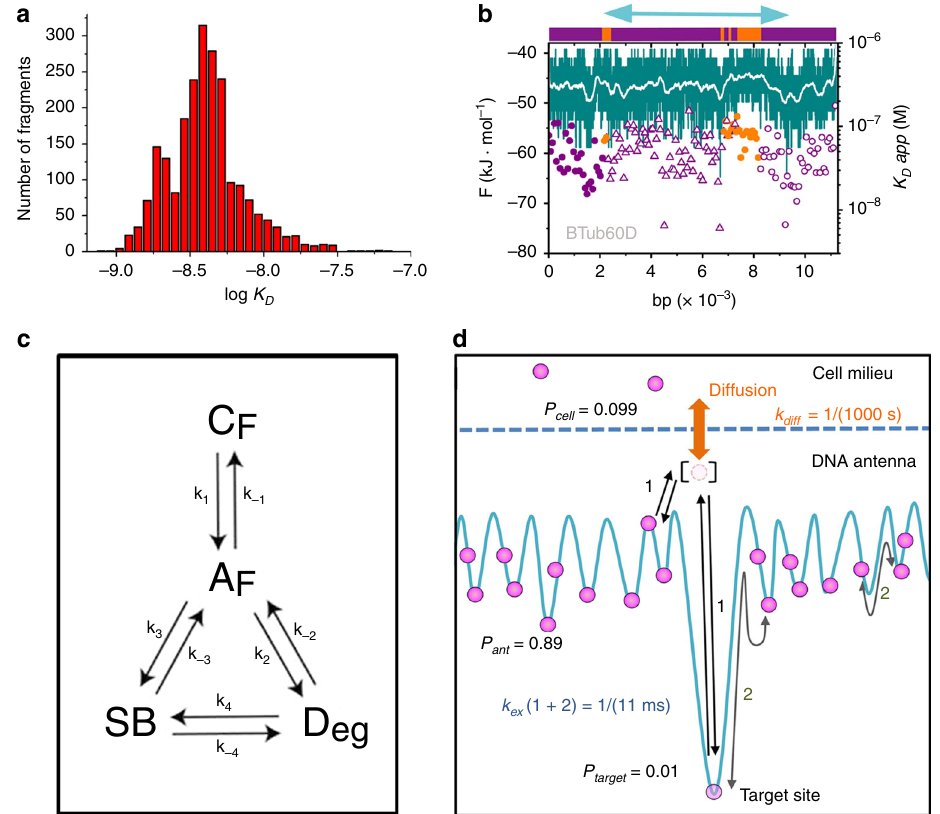
Fig. 6 Transcription antennas for tracking and controlling the gene of interest. a Histogram of binding af fi nity (in log10(Molar) units) predicted by the statistical mechanical model for all of the DNA fragments (between 100 and 476bp long) from the Drosophila genome identi fi ed to bind to EngHD in ChIP-Seq experiments on transgenic fl ies expressing en-GFP fusion proteins (ENCODE project experiment ENCSR952TDU). b Pro fi le for EngHD binding to the extended (including 2 kbp before and after) β 3 tubulin gene (FlyBase code β tub60d, corresponding to the chromosome region: 2R 24,305,881 – 24,313,099) calculated with the statistical mechanical model. The gene organization is shown as a bar on top (exons in orange; 5 ′ UTR, 3 ′ UTR and introns in purple). Dissociation constants calculated for successive regions of 75 bp follow the same color scheme with closed circles for 5 ′ UTR and exons, open circles for 3 ′ UTR and open triangles for introns. The light blue arrow on top signals the speci fi c region synthesized for the binding experiments of Fig. 5c. The binding free energy for the coding strand is shown in teal. c The four-state model describing the kinetic operation of a transcription antenna. The description of the model (states and rate constants) and its physical properties are given in Methods. d Diagram representing the β 3 tubulin transcription antenna four-state kinetic model implemented with parameters inspired by our experimental results (see Methods). Hundreds of degenerate binding sites ( p ant is the population of D eg ) are in fast exchange with each other and with the speci fi c target site ( p target is the population of SB ) by dissociation and rebinding events within the antenna (1) and by 1D diffusion population of free EngHD molecules within the antenna (square brackets, A F ) and EngHD molecules outside of the